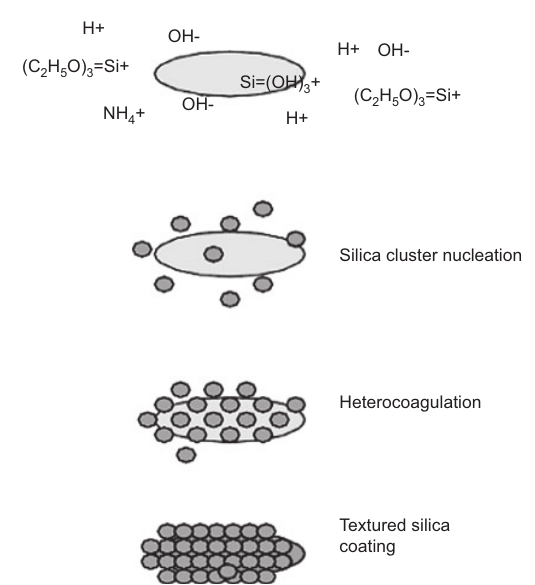
Figure 7 Heterocoagulation-based coating mechanism for the surface modifi cation of HAP particles with